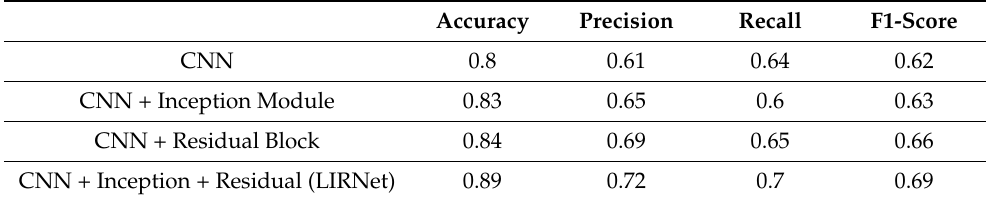
Table 7. The ablation experiments of with/without the inception module and residual